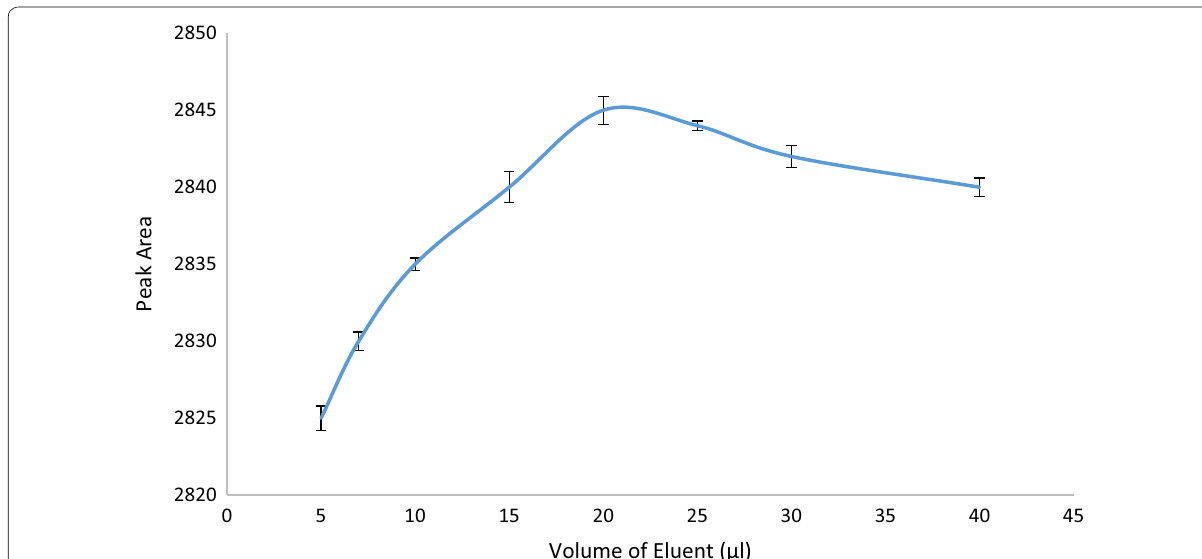
Fig. 9 Effect of volume of eluent on extraction efficiency of CBZ (Experimental conditions: pH: 7.5; sample volume: 100 µL; number of draw/eject cycle for sample solution and eluent: 10